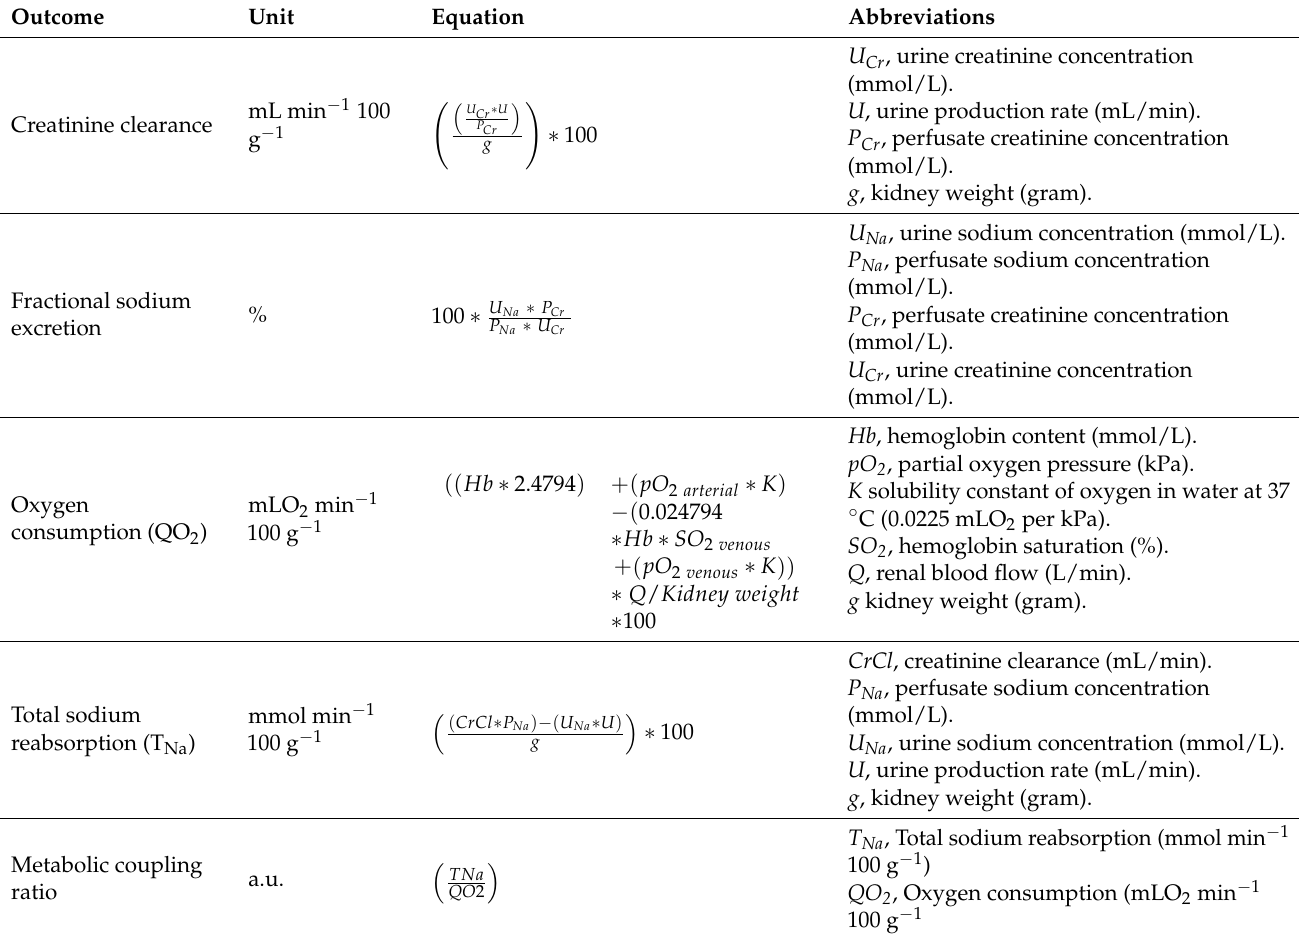
Table 3. Equations for calculating renal metabolic and functional